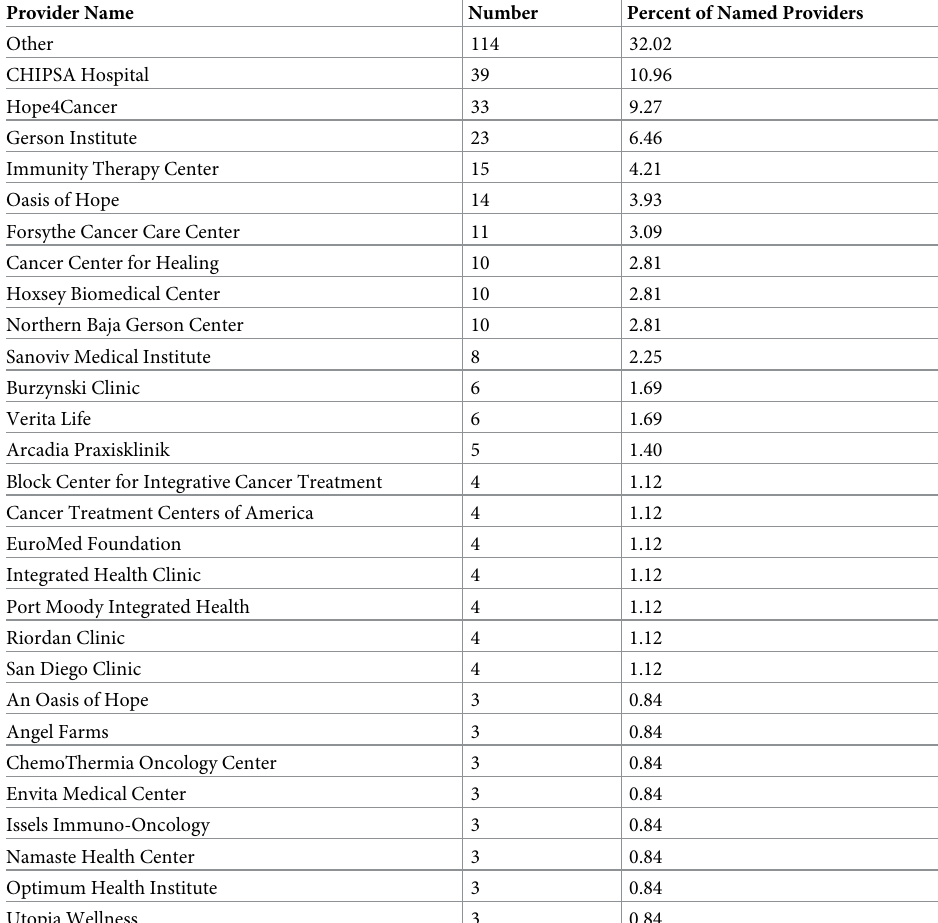
Table 7. CAM provider